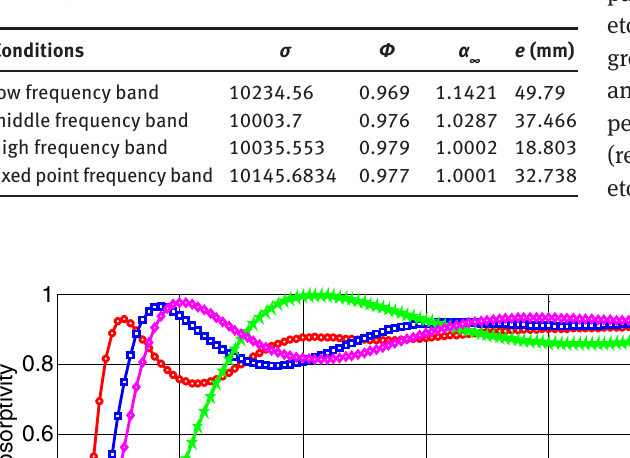
Table 2: On-demand optimization parameters of PM at different frequency bands.